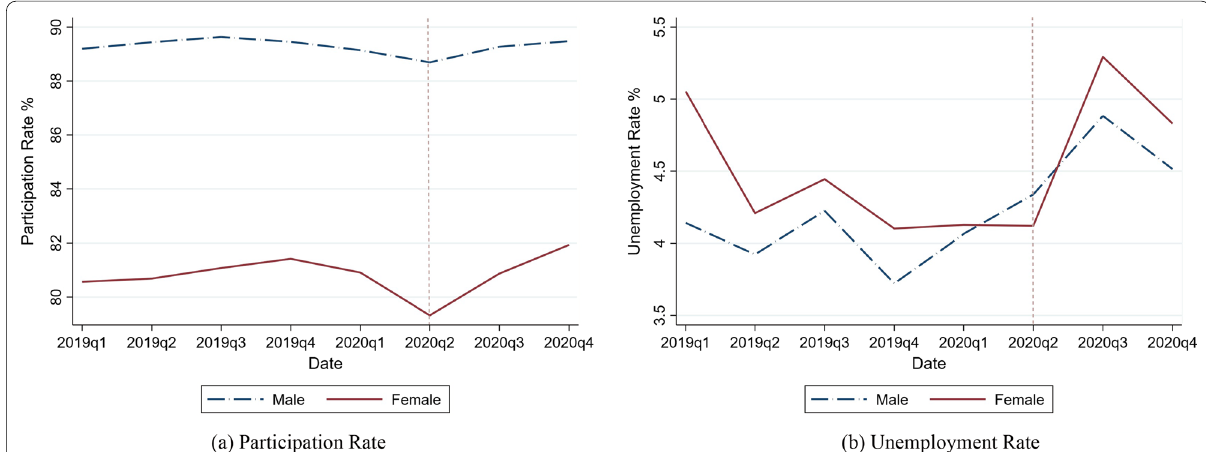
Fig. 1 Labor market status by gender. Notes The participation rate is measured as the number of working-age respondents in the labor force as a percentage of the total number of working-age respondents. The unemployment rate is calculated as the number of working-age respondents